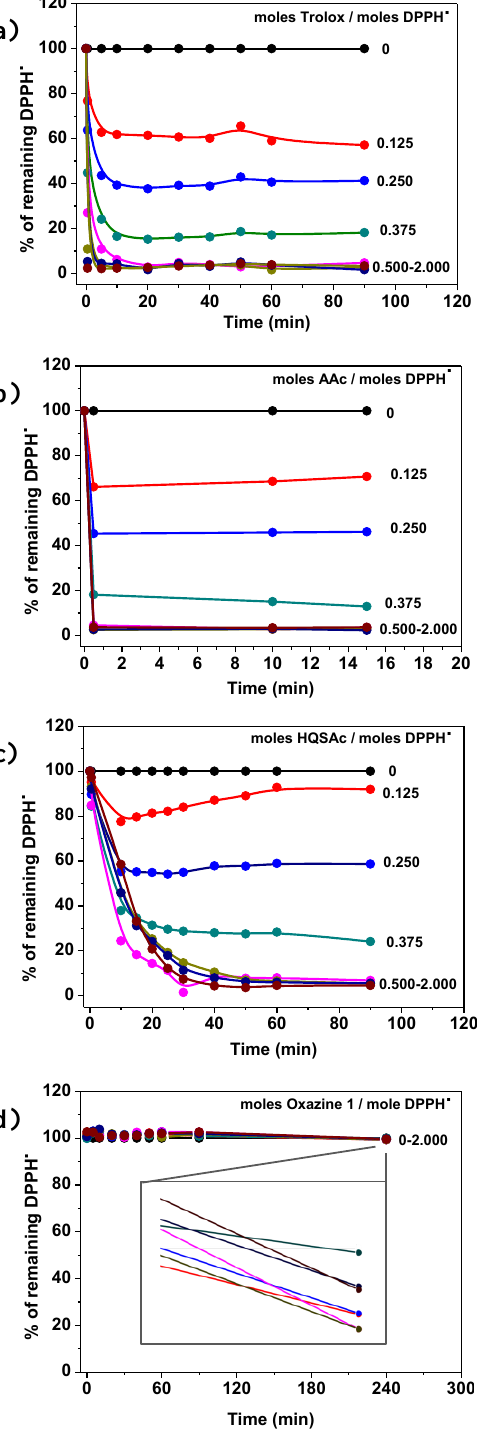
Figure 6. Reaction respond curves and rEC 50 determined by inhibition of 2,2-diphenyl-1-picrylhydrazyl (DPPH) radical. ( a ) Trolox; ( b ) AAc; ( c ) HQSAc and ( d ) Oxazine 1 .